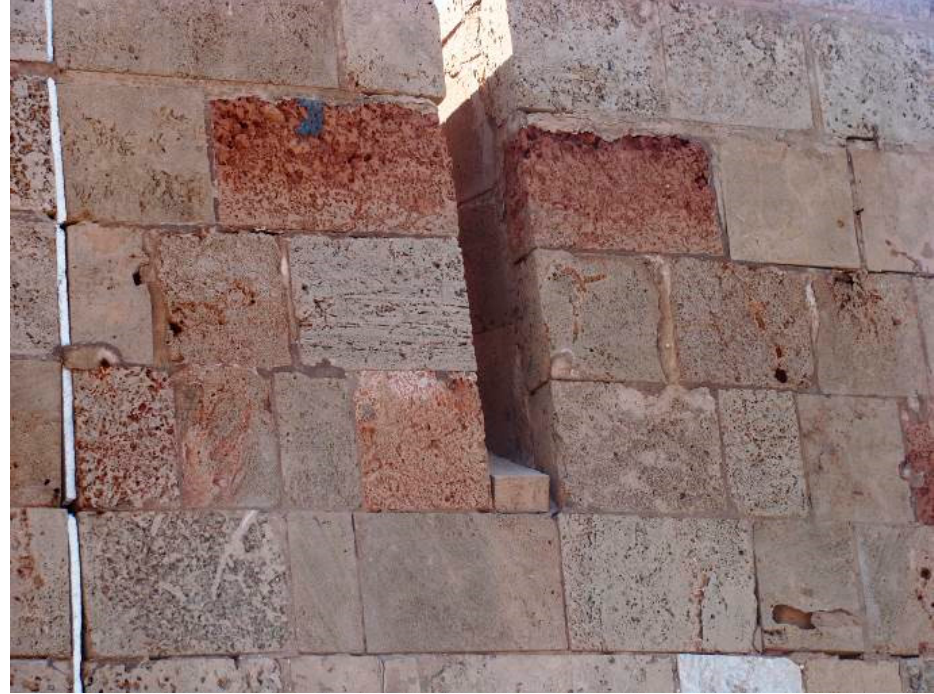
Figure 10. The coloration of kurkar siding in the Panorama sea walls. Captured by the author on 27 November 2018.